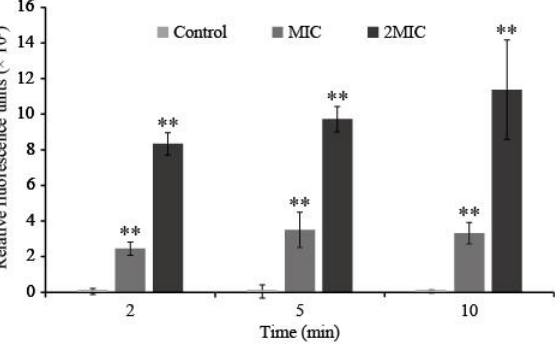
Figure 4. Cell membrane potential of C. sakazakii treated with LC-EO (** p < 0.01).